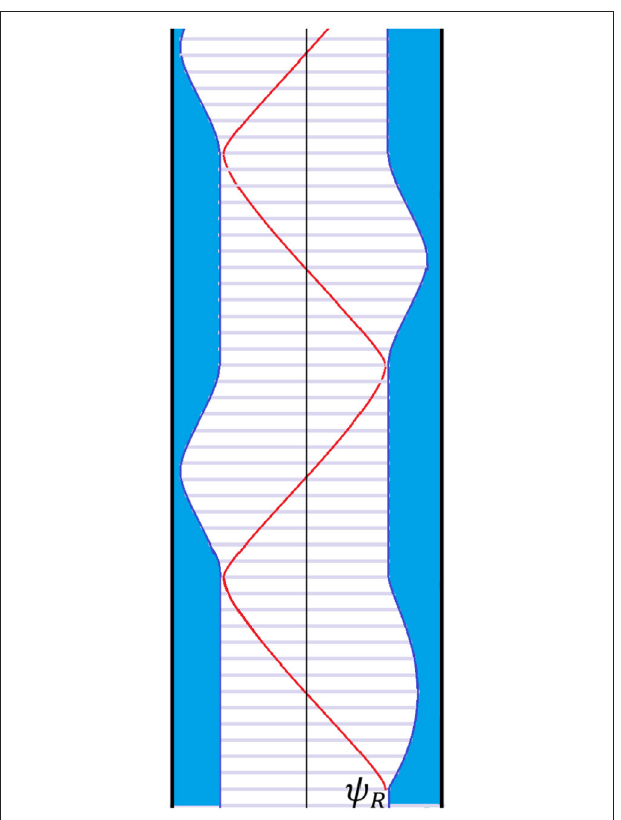
FIGURE 13 | A particle has been added to the right side of the traversable wormhole by acting with ψ . The subsequent motion is oscillatory with periodic variation in the distance between the boundaries, thus indicating periodic variation of complexity. The figure has been foliated with constant time slices to help guide the eye. The oscillations of the boundary are very small and have been greatly